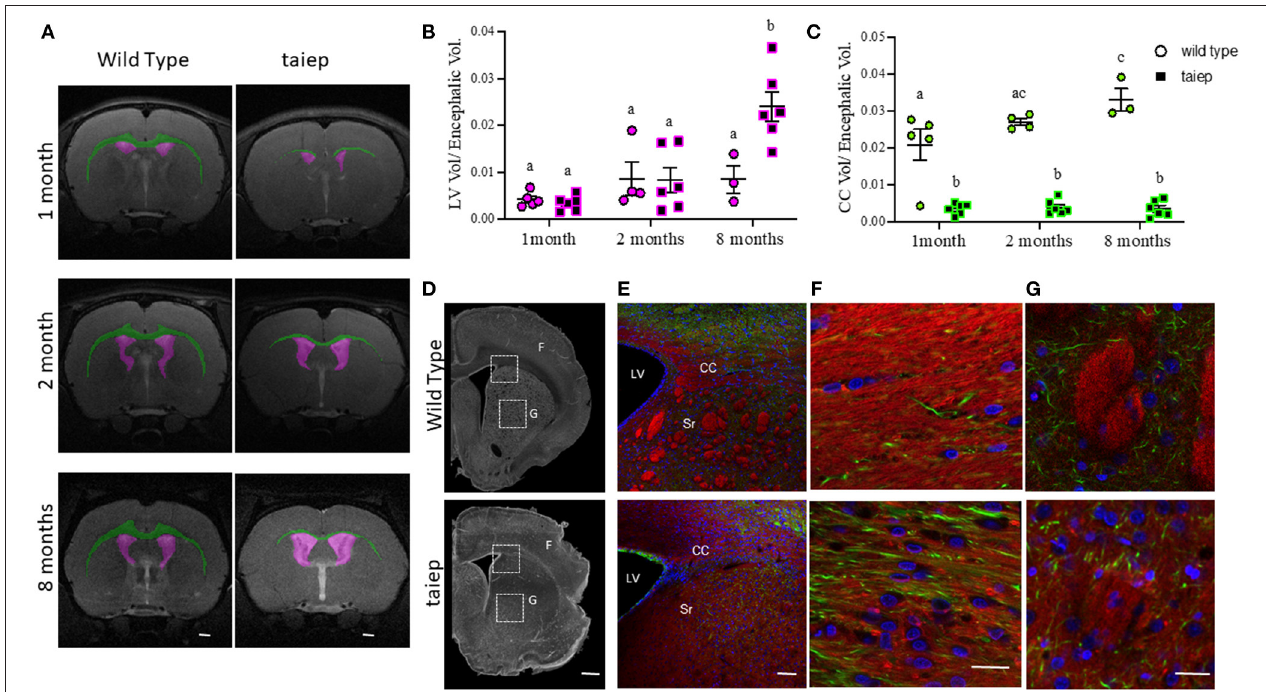
FIGURE 6 | Anatomical and histological matched analysis of corpus callosum in taiep and wild-type rats at different stages of development. Representative images of T2-weighted coronal sections illustrating individual masks in the brain structures of interest at 1, 2, and 8 months. Lateral ventricles in magenta and corpus callosum in green (A) . The volume ratio was calculated as structure volume/encephalon volume (in mm 3 ) at the same age (B,C) . Scatter plot of the values of LV volume ratio (B) and CC volume ratio (C) . Each dot represents the data from one rat (at least n = 3 for each group). Two-way ANOVA followed by Tukey’s multiple comparison test was done. Different letters indicate significant differences between groups. Representative coronal slices of corpus callosum and striatum of WT and taiep rat brains (10 months) acquired by phase contrast microscopy (D) . Myelin (red) and neurofilaments (green) were revealed by immunofluorescence (E–G) . Amplifications of white squares for merge and separated channels are shown in (F) . Striatum (G) . Nuclei were revealed by DAPI (blue). Scale bars: 1,000 µ m (D) , 20 µ m (E) , 5 µ m (F) , and 100 µ m (G) . LV, lateral ventricle; CC, corpus callosum; Sr,